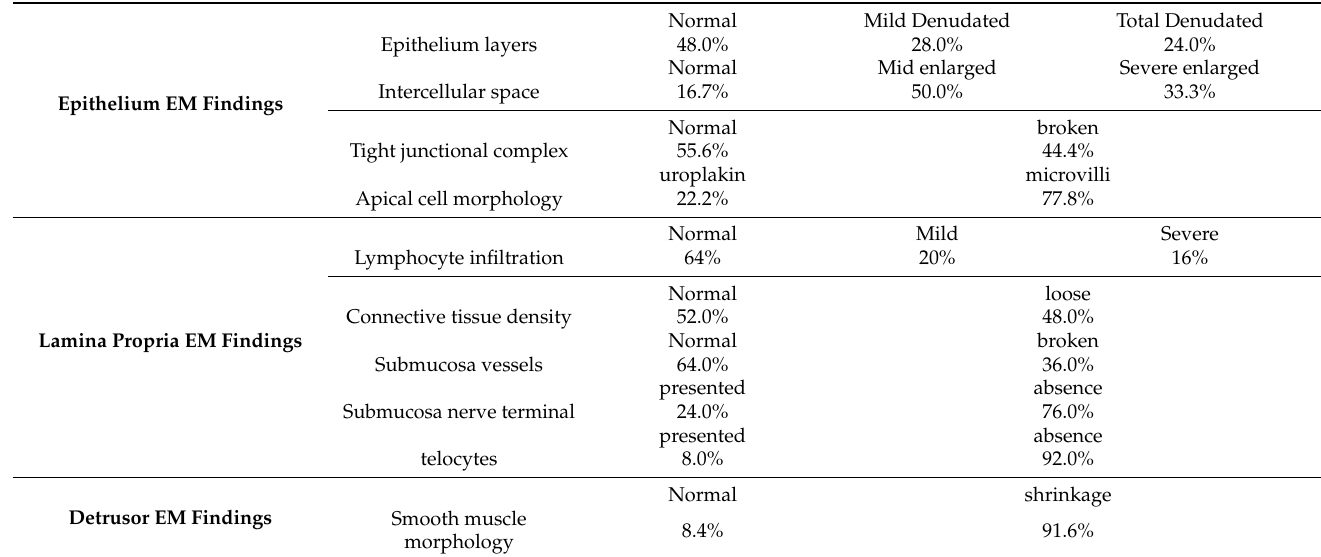
Table 2. Proportion of EM bladder defects in patients with DU.